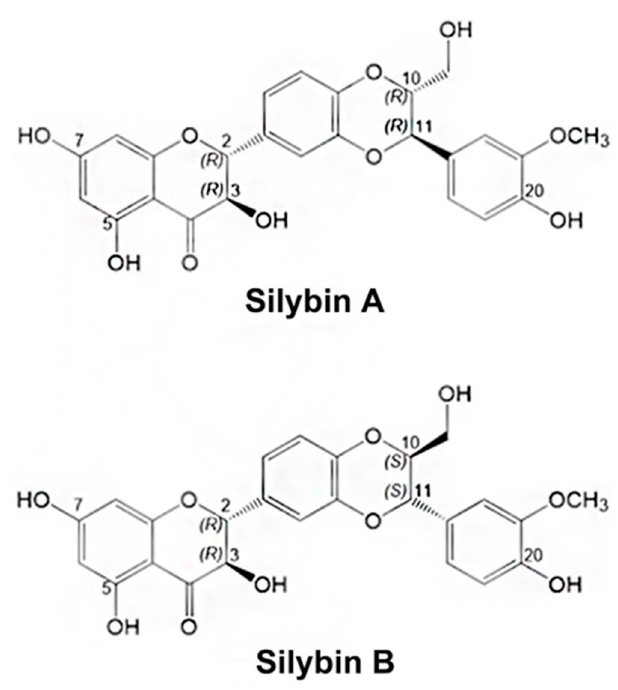
Figure 1. Chemical structures of silybin diastereomers.